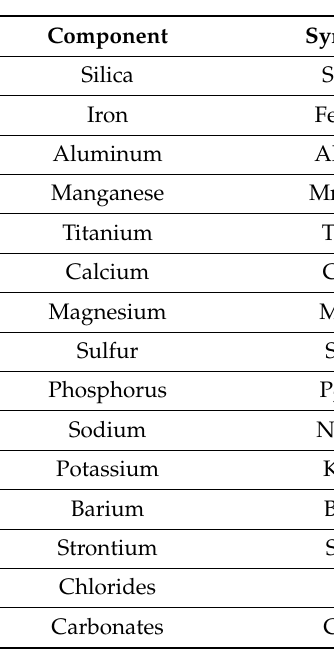
Table 2. Methods of ash composition